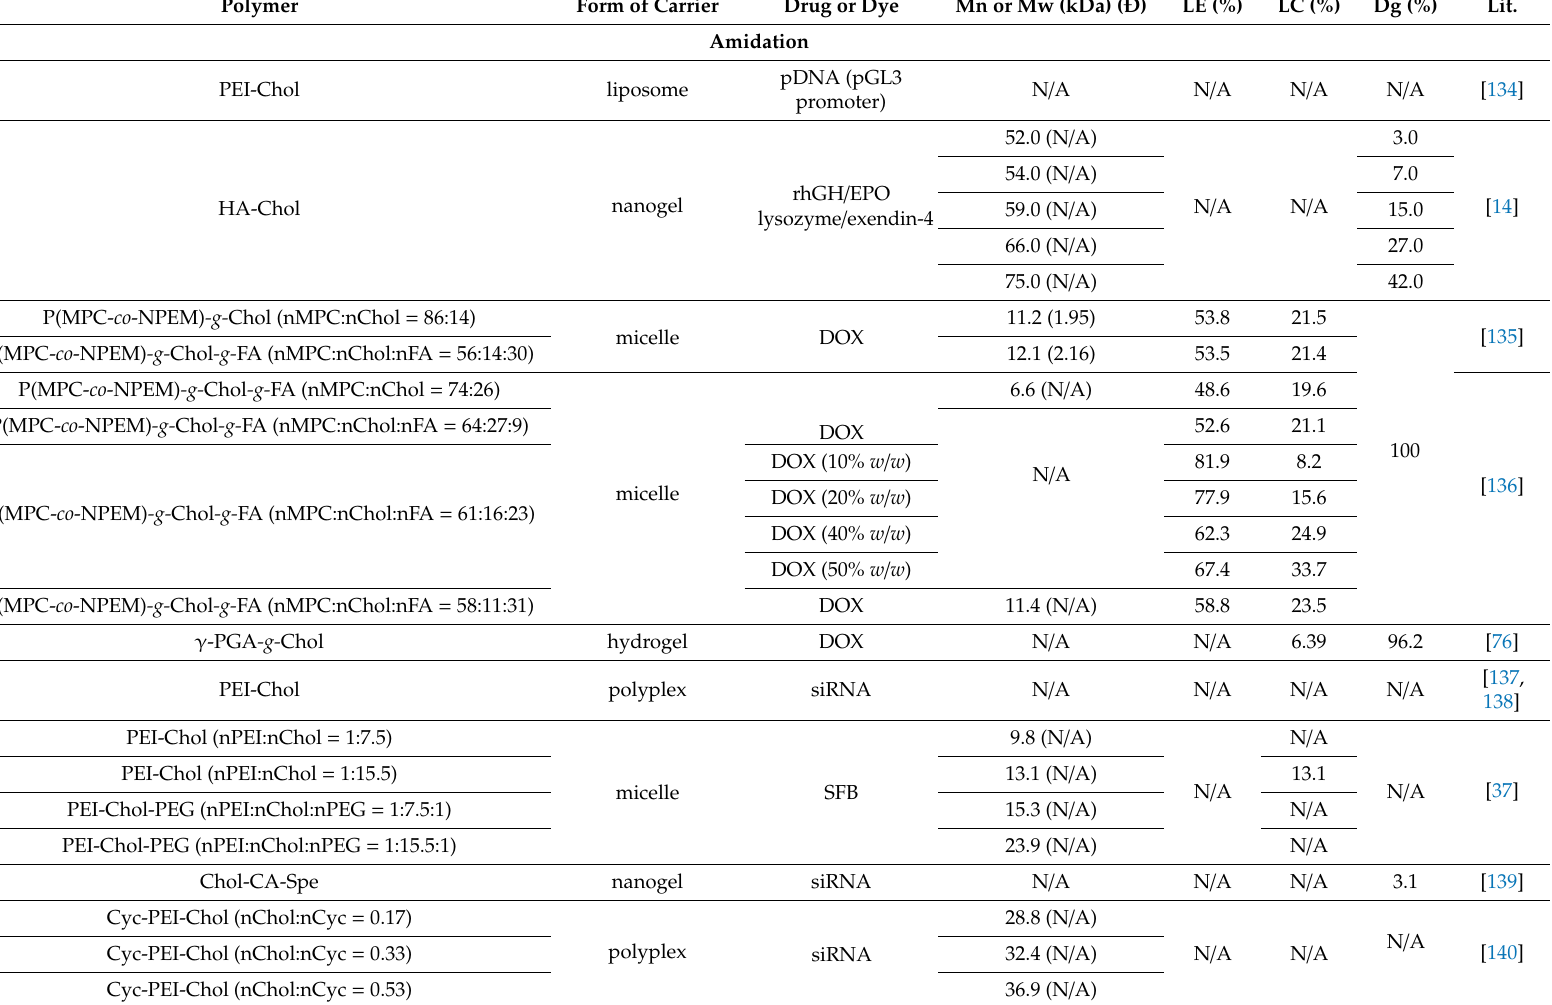
Table 4. Polymers containing cholesterol moieties in side chains introduced by